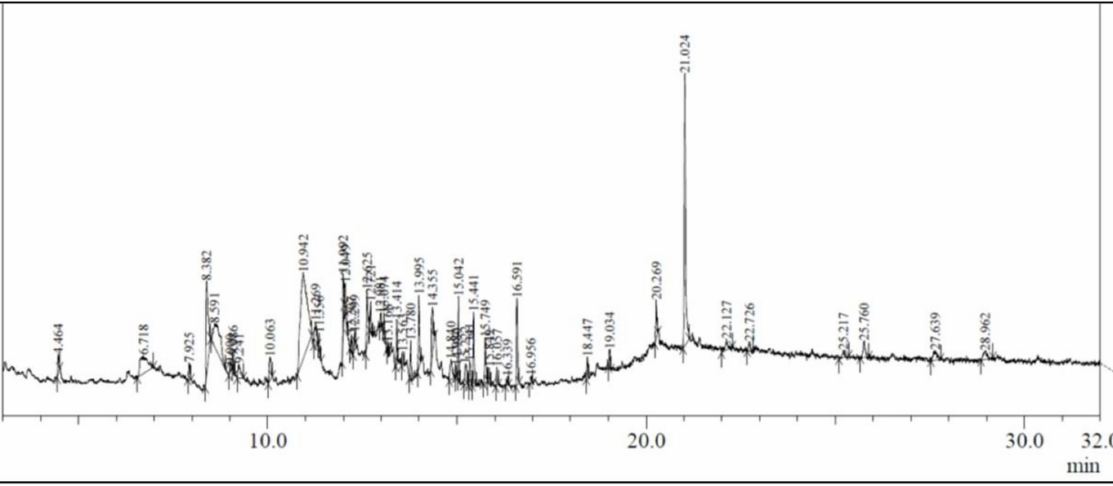
Figure 1. GC-MS chromatogram of the ethanolic extract of Artemisia vulgaris